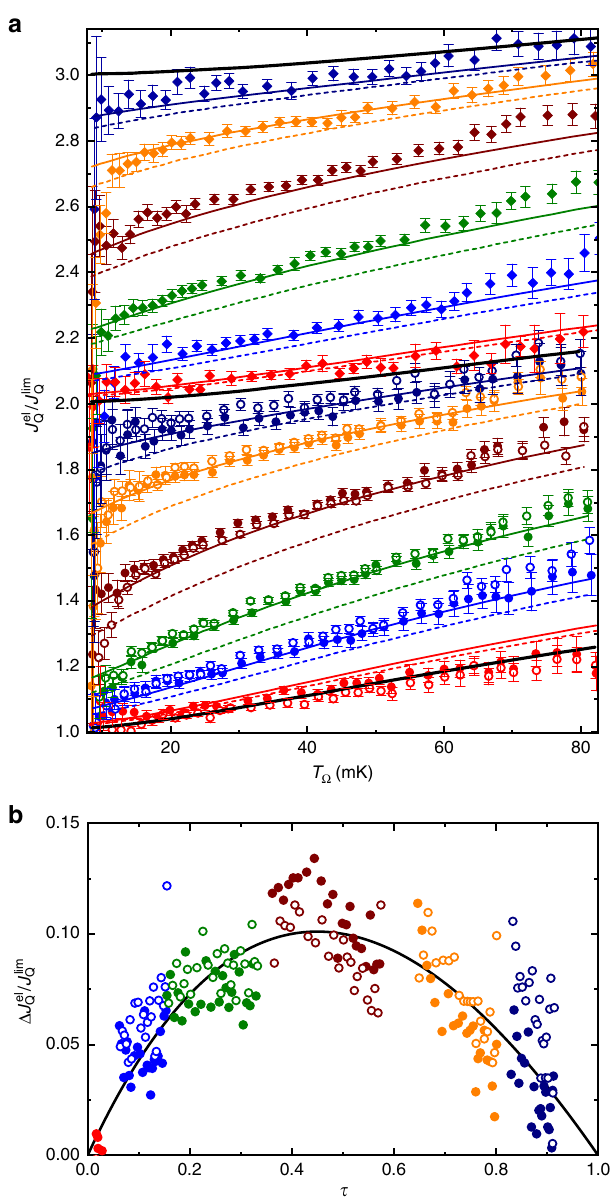
Fig. 3 Electronic heat fl ow. a Experimental J el Q = J lim Q (with J lim Q ¼ π 2 k 2 ð T 2 Ω (cid:3) T 2 Þ = 6 h ) are plotted as symbols versus T Ω with N ¼ 2 (circles) and N ¼ 3 (diamonds), for a broad range of QPC tunings (colors). Error bars represent the standard statistical error. Black continuous lines are predictions at τ ¼ 0 for N ¼ 2 (bottom), 3 (middle), and 4 (top). Dashed lines are interpolations between ballistic predictions, linear in the measured τ . Continuous lines are theoretical predictions. b Symbols represent the difference Δ J el Q between experimental J el Q ( N ¼ 2, T Ω 2 ½ 17 ; 65 (cid:2) mK in panel a ) and the corresponding interpolation between ballistic predictions, normalized by J lim Q . The continuous line displays versus τ the low- temperature prediction τ ð 1 (cid:3) τ Þ = ð N þ τ Þ for N ¼